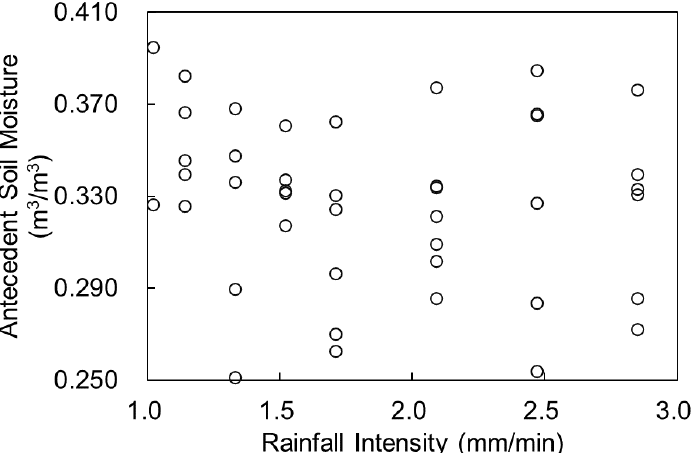
Figure 1. The rainfall intensity and initial soil moisture in different experimental scenarios (each circle corresponds to an experimental scenario).